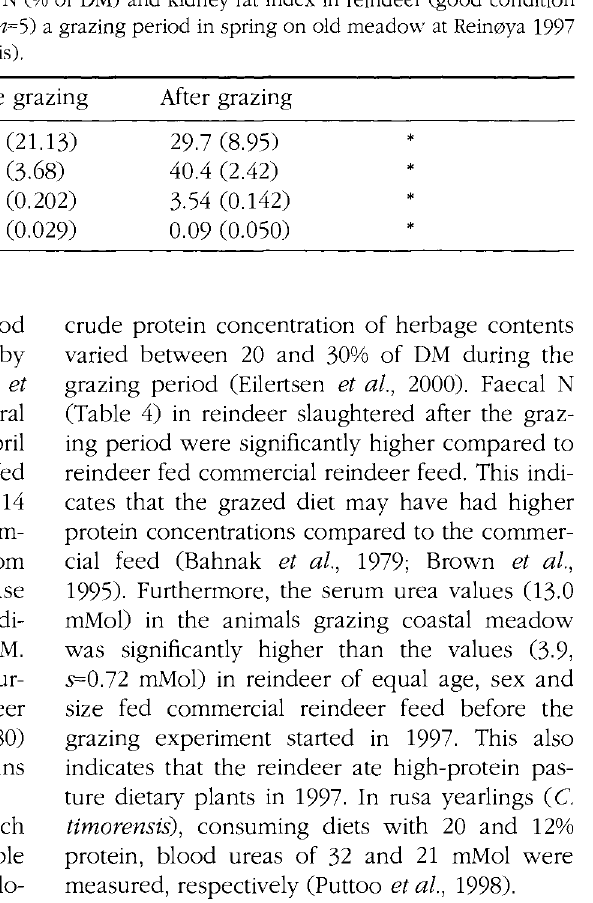
Table 4. Marrow fat, rumen NDF content (%), faecal N (% of DM) and kidney fat index in reindeer (good condition group) slaughtered before (w=5) and after («=5) a grazing period in spring on old meadow at Reinøya 1997 (mean with standard deviation in